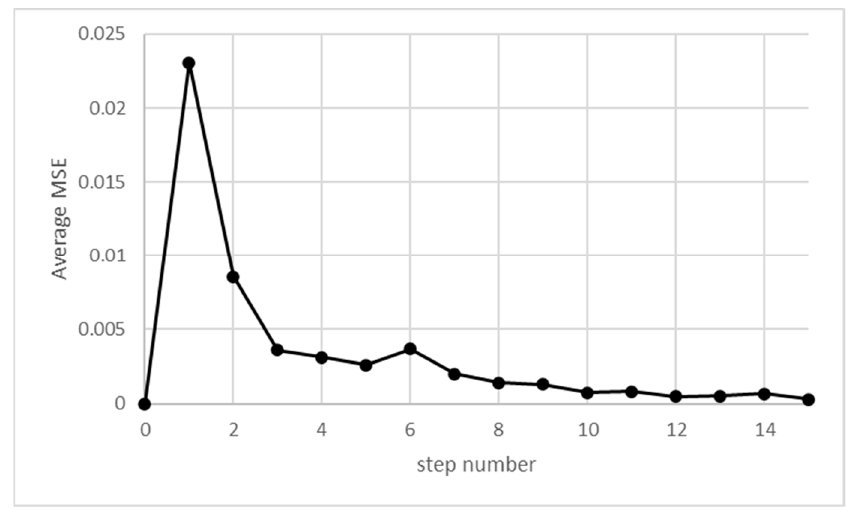
Figure 4. MSE between simulated and analytical results as a function of simulation steps.